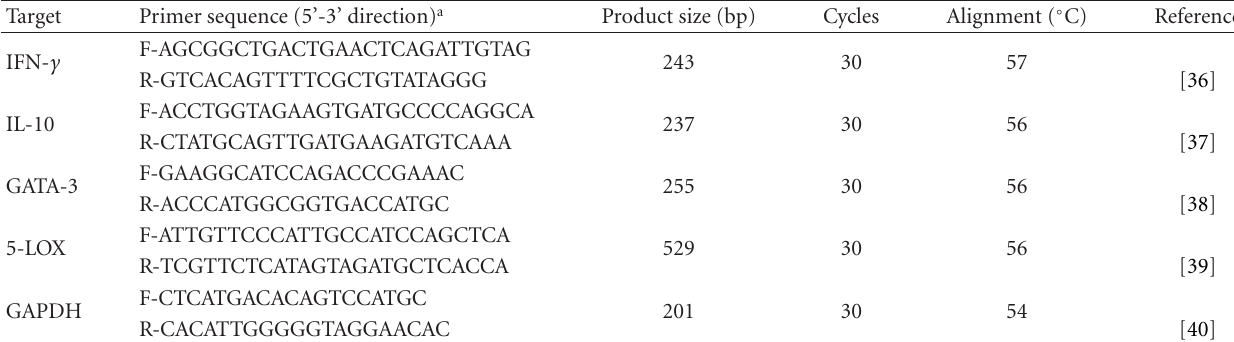
Table 1: Oligonucleotide primers used for gene expression analysis by